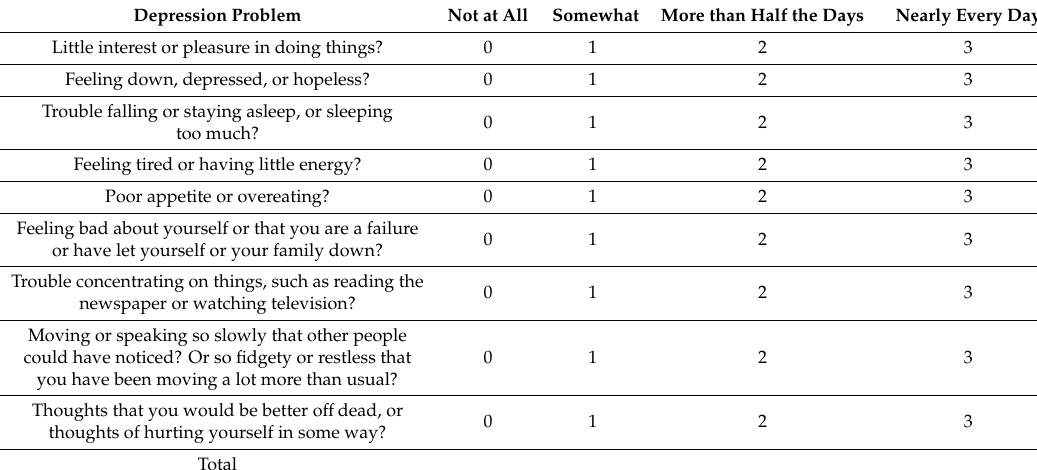
Table A1. Patient Health Questionnaire-9